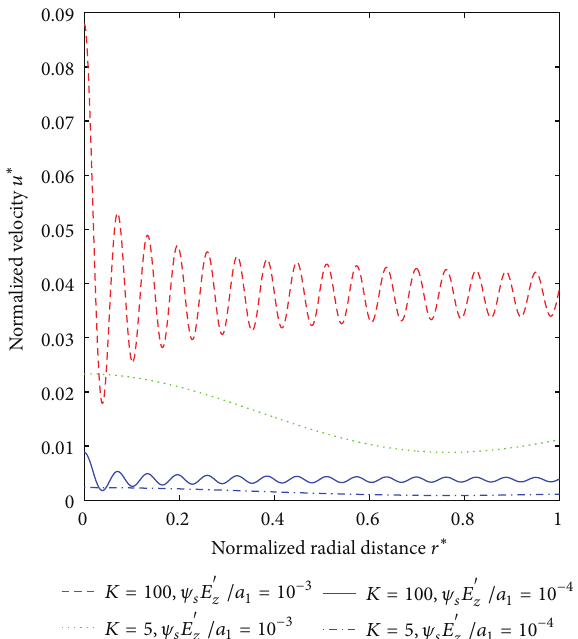
Figure 2: Typical profiles of the velocity component due to electric field for 𝑙 ∗ = 0.5 under different 𝜓 𝑠 𝐸 󸀠 𝑧 /𝑎 1 and 𝐾 values.